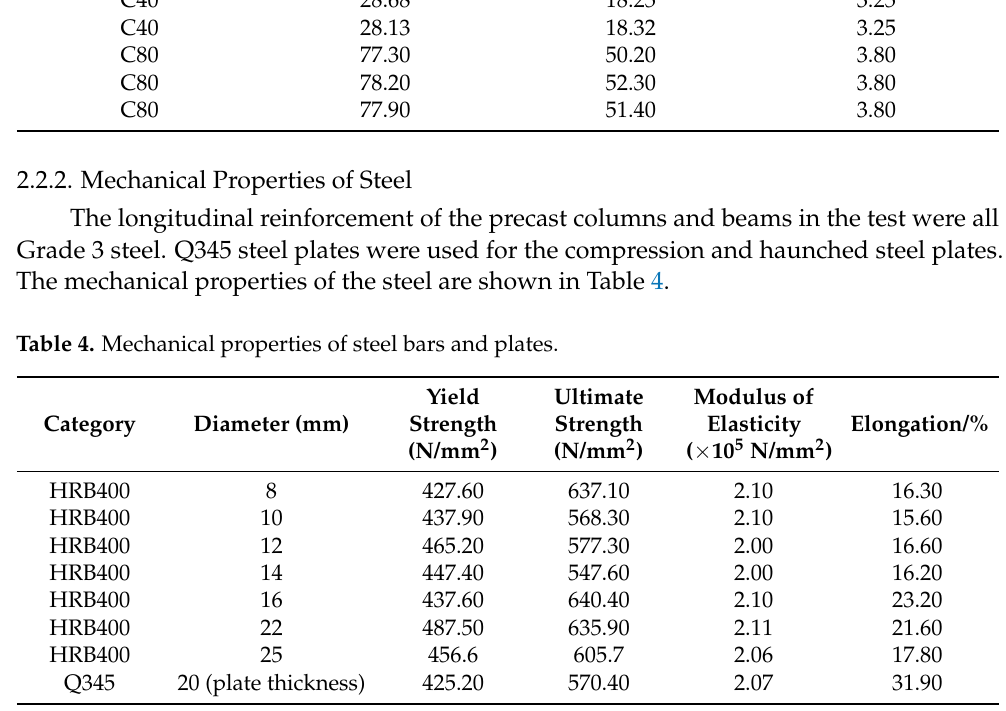
( b ) Figure 7. Brace and loading regime of specimens. ( a ) Loading device diagram; ( b ) loading site plan. In accordance with the code [36], in the first step, a constant axial force was applied at the top of the column, which was kept constant during the test, and the axial force was applied according to an axial pressure ratio of 0.05. In the second step, a symmetrical low- cycle reciprocating displacement was applied to the beam using electro-hydraulic servo actuators. The whole test loading was carried out in two stages; the first stage of displace- ment loading was carried out once per load cycle and loaded until the specimen yielded. The second stage of loading still used displacement-controlled cyclic loading to carry out three cycles per stage. Stop loading when the load on the specimen has dropped to 85% of the peak load or when the bolt has bent and broken. During the loading process, always